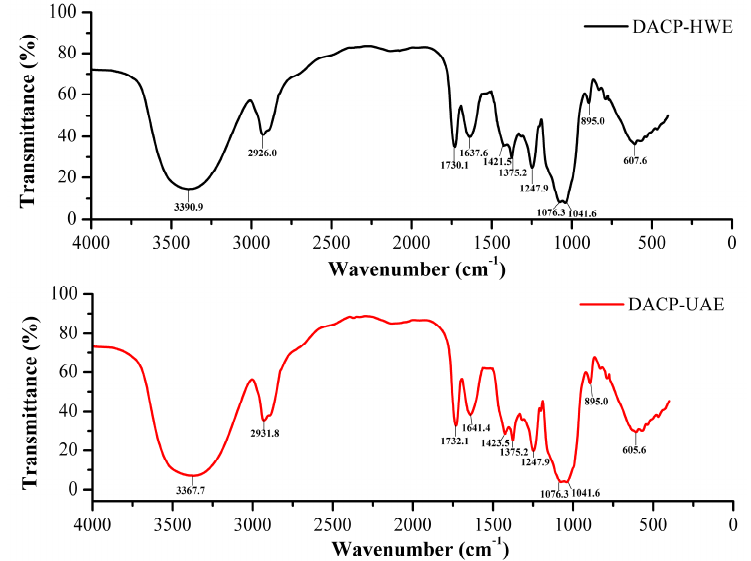
Figure 4. Fourier Transform Infrared (FTIR) spectra of dialyzed ACP (DACP)-HWE and DACP- UAE.